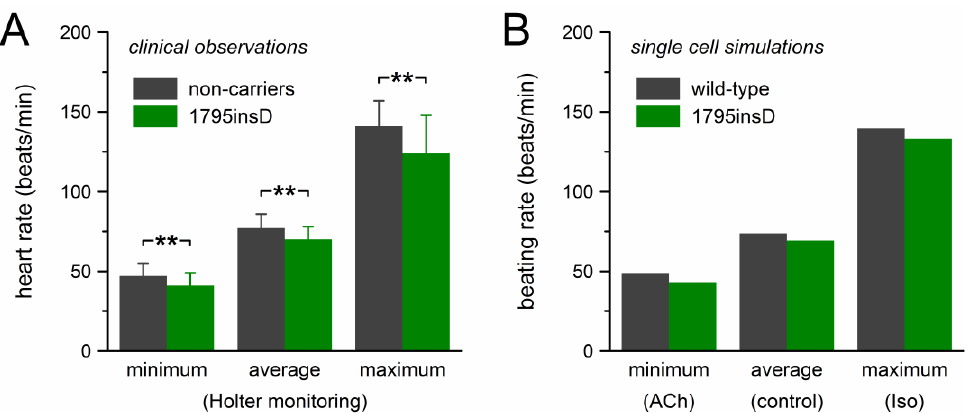
Figure 6. Bradycardic effect of the heterozygous 1795insD mutation. ( A ) Clinically observed heart rate of 1795insD mutation carriers [21]. Data are mean ± SD (cf. Table 1). ** p < 0.001. ( B ) Beating rate of the Fabbri – Severi model cell.